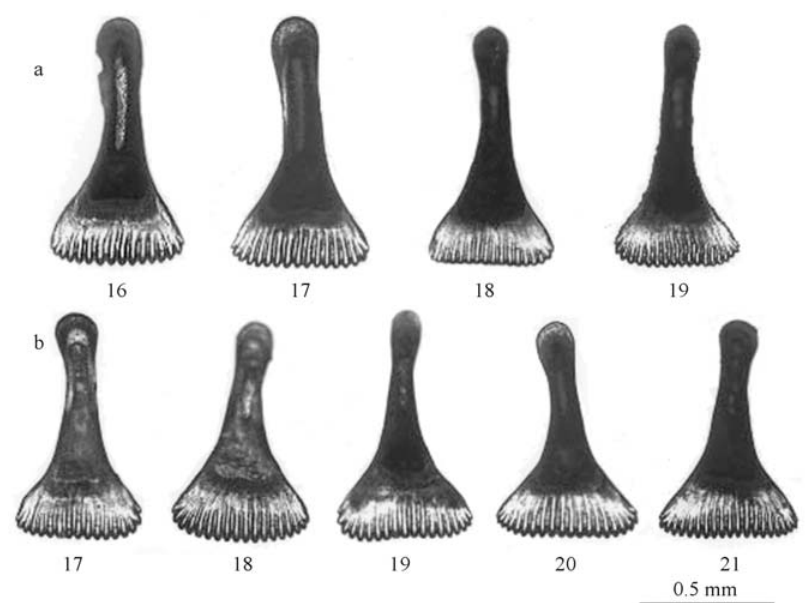
Figure 4 - Symphysean teeth of: a. Parodon tortuosus and b. Parodon nasus , with the variation of the number of cusps for each species.